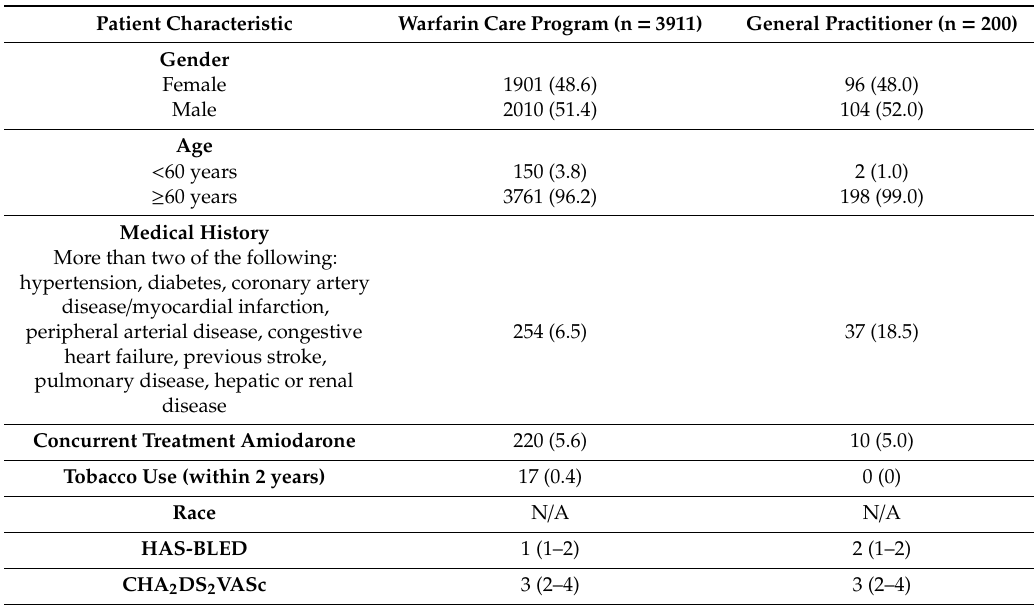
Table 1. Patient demographics in relation to variables in the predictive score for patients managed by the warfarin care program and by a general practitioner. Data is represented as number (percentage) and median (25th and 75th percentile) for HAS-BLED (Hypertension, Abnormal renal / liver function, Stroke history, Bleeding history, Labile International Normalised Ratio, Elderly, i.e., age > 65 years, Drugs / alcohol concurrently) and CHA 2 DS 2 VASc (Congestive heart failure, Hypertension, Age ≥ 75 years, Diabetes mellitus, Stroke / transient ischaemic attack, Vascular disease, Age 65-74 years, Sex – female) risk